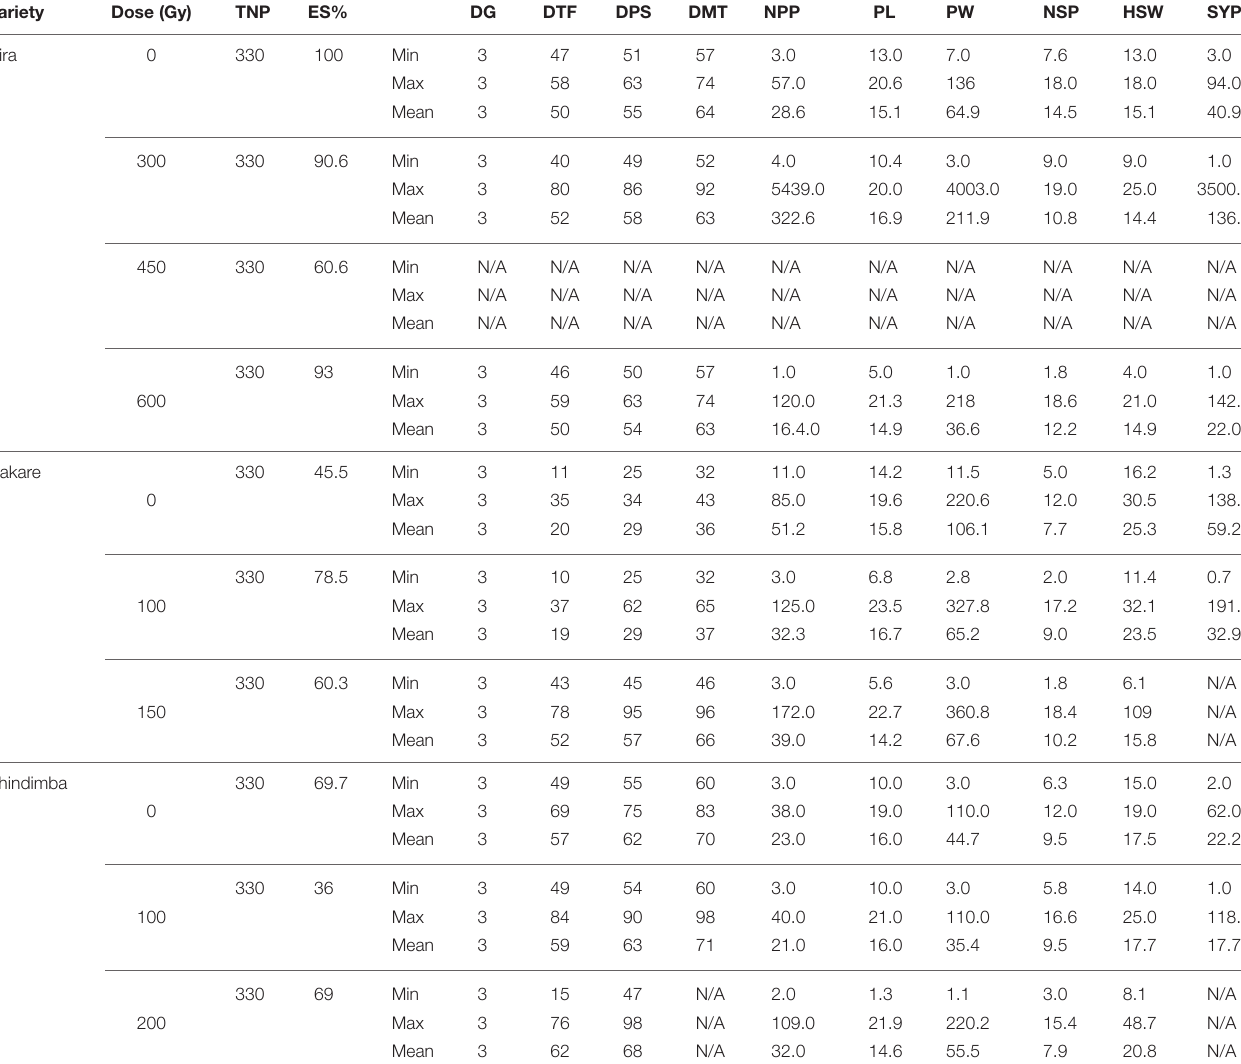
TABLE 4 | Quantitative characteristics of M 3 cowpea mutant lines irradiated at different gamma radiation doses (Gy) in relation to their parental lines/control (Gy 0) observed at Bagani Research Station during 2011/2012 season.